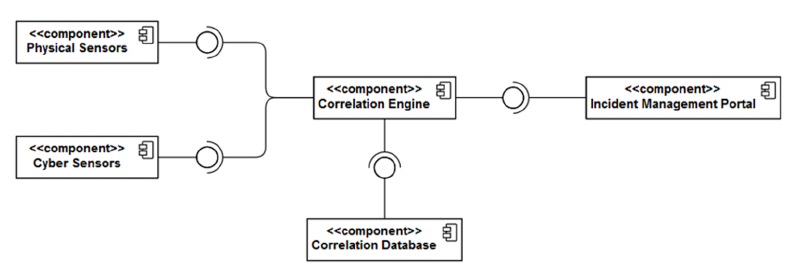
Figure 2. SATIE security ecosystem without SMS-I